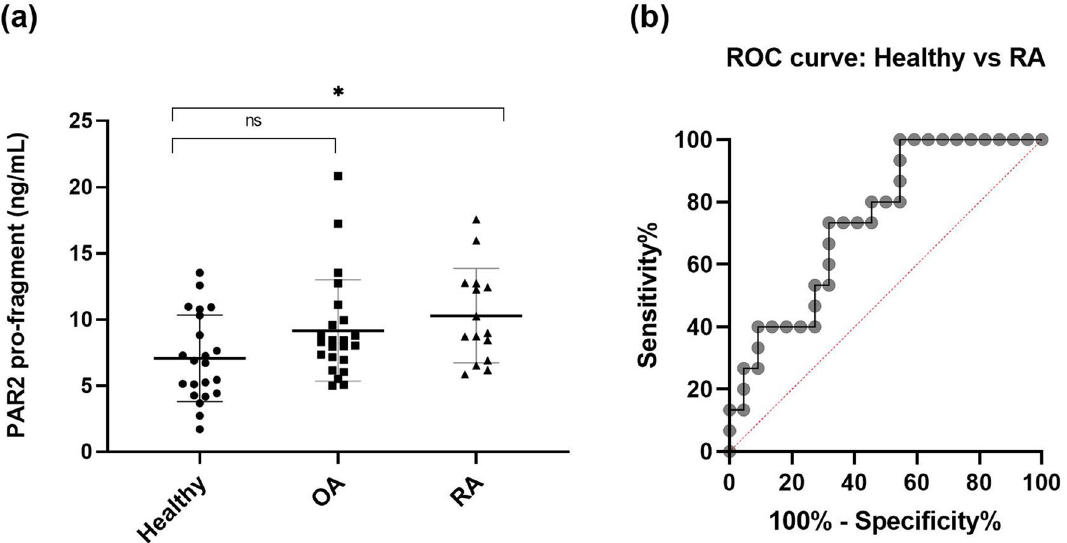
Figure 3. ( a ) Distribution of PRO-PAR2 values across the healthy human donors, OA, and RA patients. Groups were compared using the ANCOVA analysis. Differences between the groups were adjusted to age and gender. Data are presented as mean ± SD. Statistical significance is considered as * P < 0.05, ns = P > 0.05. ( b ) Receiver operating characteristics (ROC) curve analysis. This analysis was used to assess the discriminatory performance of PRO-PAR2 levels between controls and RA patients.